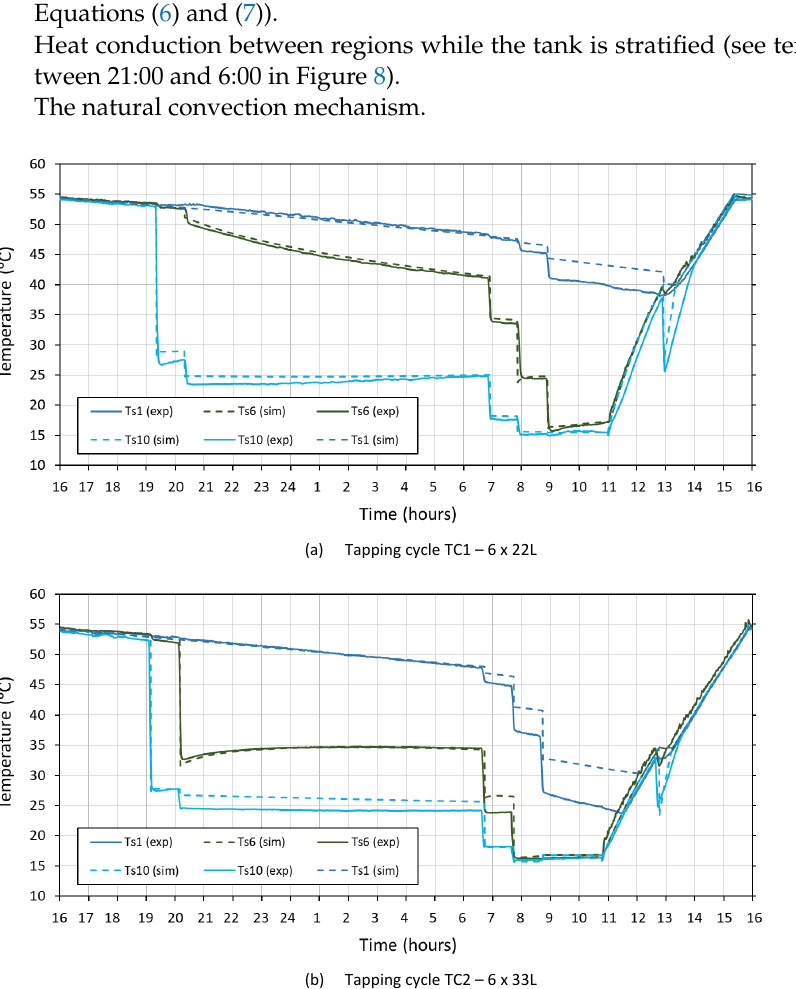
Figure 8. Water tank thermal stratification. Numerical vs. experimental results of the tank wall temperatures along the vertical axis (top: T s ,1 , bottom: T s ,10